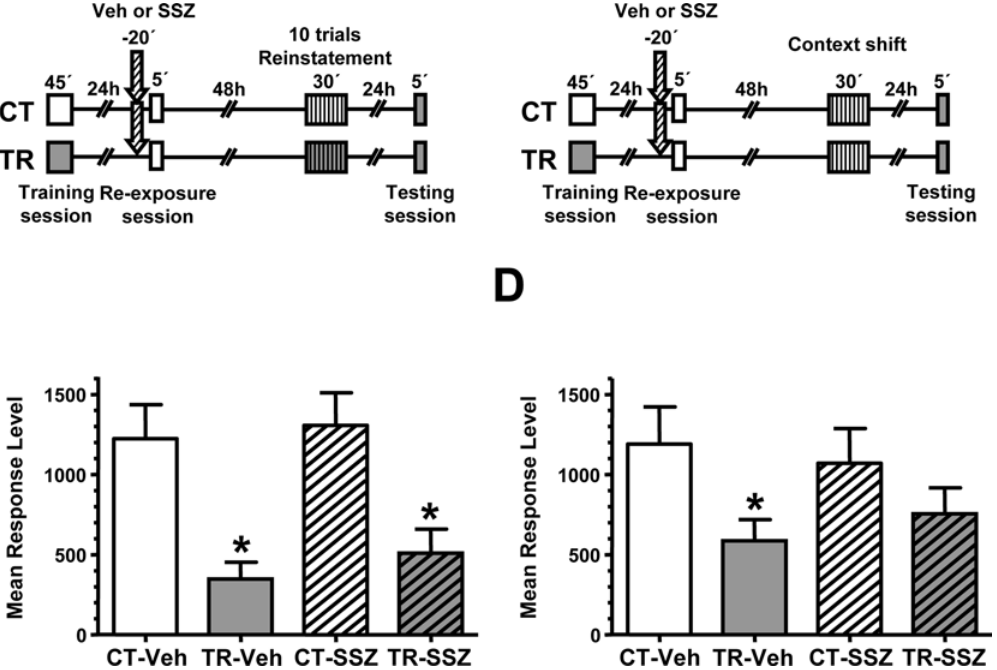
Figure 6. The reinstatement with 10 trials reveals the original memory over sulfasalazine-induced amnesia in memory reconsolidation. A. Experimental design: On day 1 the animals were trained with 15 trials (TR groups) in the context A or were located in the context but remained untrained (CT groups). On day two, a pair of CT-TR groups was injected with 6 m g/g sulfasalazine and the other with vehicle solution (indicated with arrows). 20 min later, all groups were re-exposed to the context A for 5 minutes. 48 h after re-exposure session the groups were reinstated with 10 trials in the context B. 24 h later all groups were tested for memory retention with one trial in the context A. B. Performance at testing session. C. Experimental design: On day 1 the animals were trained with 15 trials (TR groups) in the context A or were located in the context but remained untrained (CT groups). On day two, a pair of CT-TR groups was injected with 6 m g/g sulfasalazine and the other with vehicle solution (indicated with arrows). 20 min later, all groups were re-exposed to the context A for 5 minutes. 48 h after re-exposure session the groups were exposed to the context B for 30 minutes. 24 h later all groups were tested for memory retention with one trial in the context A. D. Performance at testing session. Values are Mean Response Level 6 SEM at testing. *, p , 0.05.